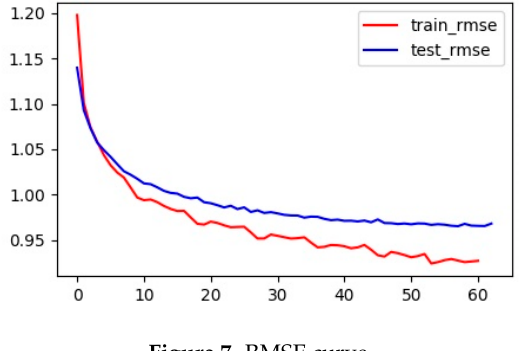
Figure 7. RMSE Figure 7. RMSE curve.